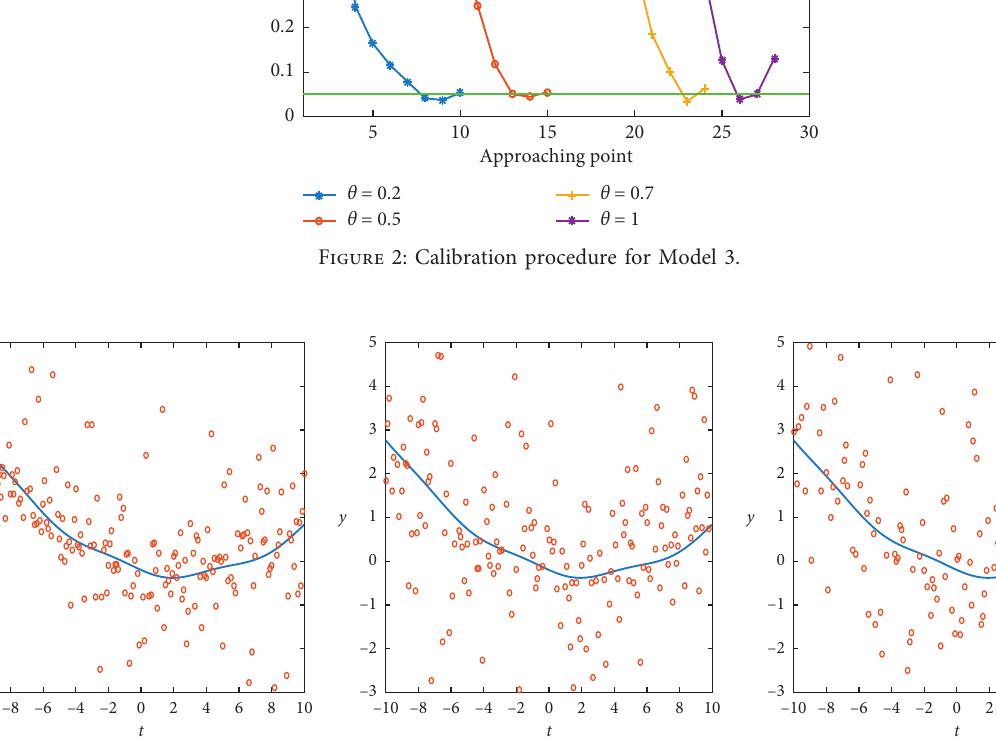
� 0, c � 0.5. (b) x � 0, 0 0